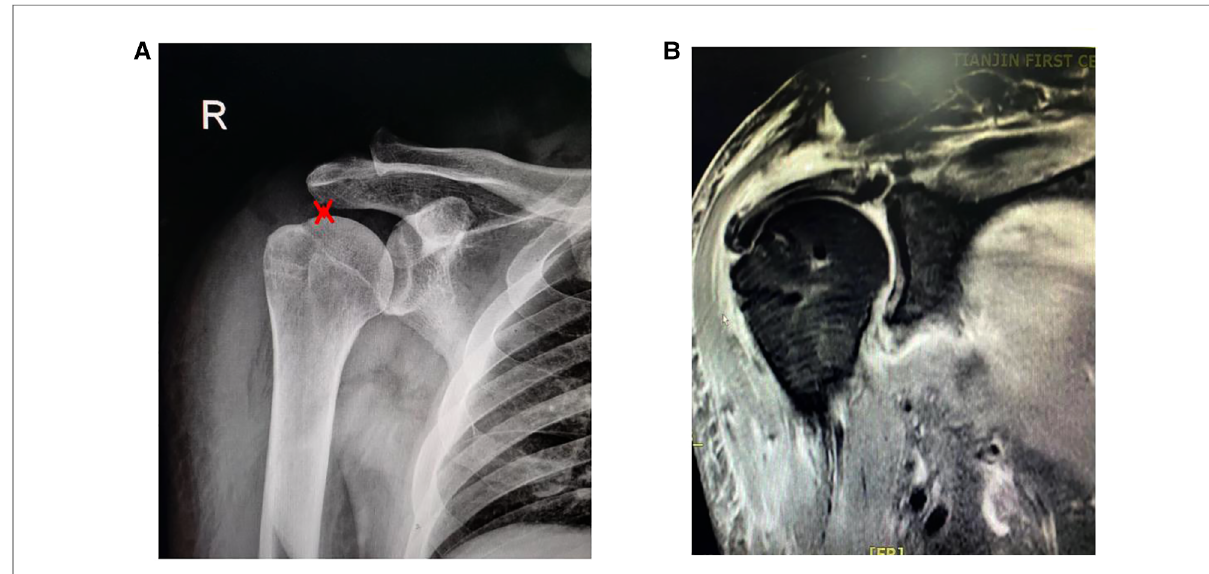
FIGURE 4 Postoperative radiograph of arthroscopic superior capsule reconstruction (1 month). ( A ) Red mark on the X-ray shows that the AHD is 9.5 mm; ( B ) the fascia lata medial side attached to the superior glenoid at 10 – 11 o ’ clock and 11 – 12 o ’ clock positions in the right shoulder, using two fully-threaded titanium suture anchors (diameter, 5 mm; suture anchor,